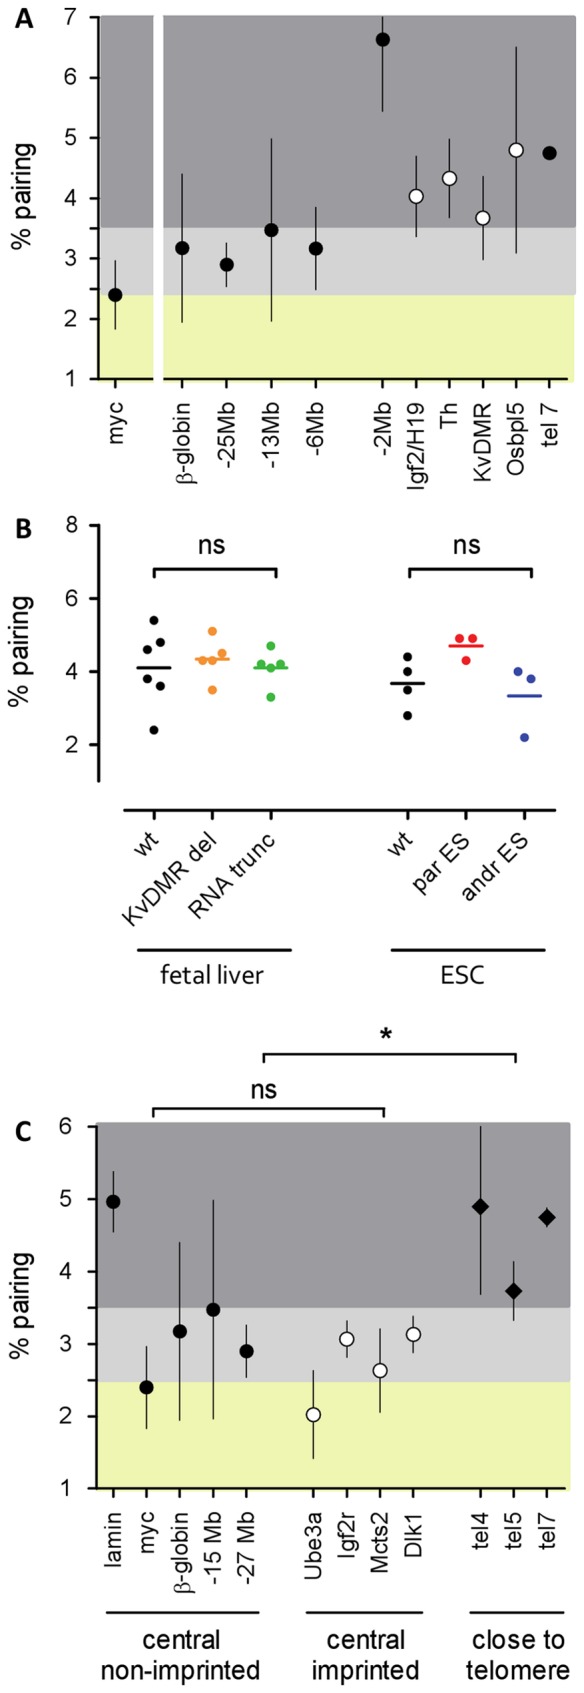
Pairing is not limited to monoallelically expressed regions.
A) Extent of paired region on chromosome 7 in ES cells. Each dot represents the mean of three to four samples taken from different passages with the pairing frequency determined for each sample in four technical replicates of 300 nuclei. Whiskers represent standard deviation. Probes from the imprinted region on distal chromosome 7 are shown as open circles, probes from non-imprinted regions are shown as filled circles. Background shading indicates high pairing frequency (dark grey, above 3.5%), medium (light grey, 2.5–3.5%) and low pairing frequency (yellow, below 2.5%). The myc probe (chromosome 15) is displayed for comparison. Frequent pairing is observed for the distal end of chromosome 7 but not limited to the imprinted region. B) Pairing in imprinting deficient mutants. Each dot represents one biological sample with the pairing frequency determined in four technical replicates of 300 nuclei. The mean is represented by a line. Differences were assessed by unpaired t-test, ns: not significant. Wt: wildtype, KvDMR del: paternal deletion of KvDMR abolishing regional silencing and removing functionally important CTCF binding sites, RNA trunc: paternal truncation of the non-coding RNA Kcnq1ot1 responsible for monoallelic silencing, par ES: parthenogenetic ES cells harbouring two maternal genomes, andr ES: androgenetic ES cells harbouring two paternal genomes. Neither the monoallelic expression state nor the presence of a biparental genome is a prerequisite for frequent pairing in the region. C) Pairing of other imprinted and telomeric regions in ES cells. For a description of data points and background see A. Differences were assessed by unpaired t-test, ns: not significant, *: p<0.05. Imprinted regions are represented by open circles, regions close to the telomere by filled diamonds. Probes covering genes in various imprinted regions do not display high pairing frequency in contrast to probes located near telomeres.